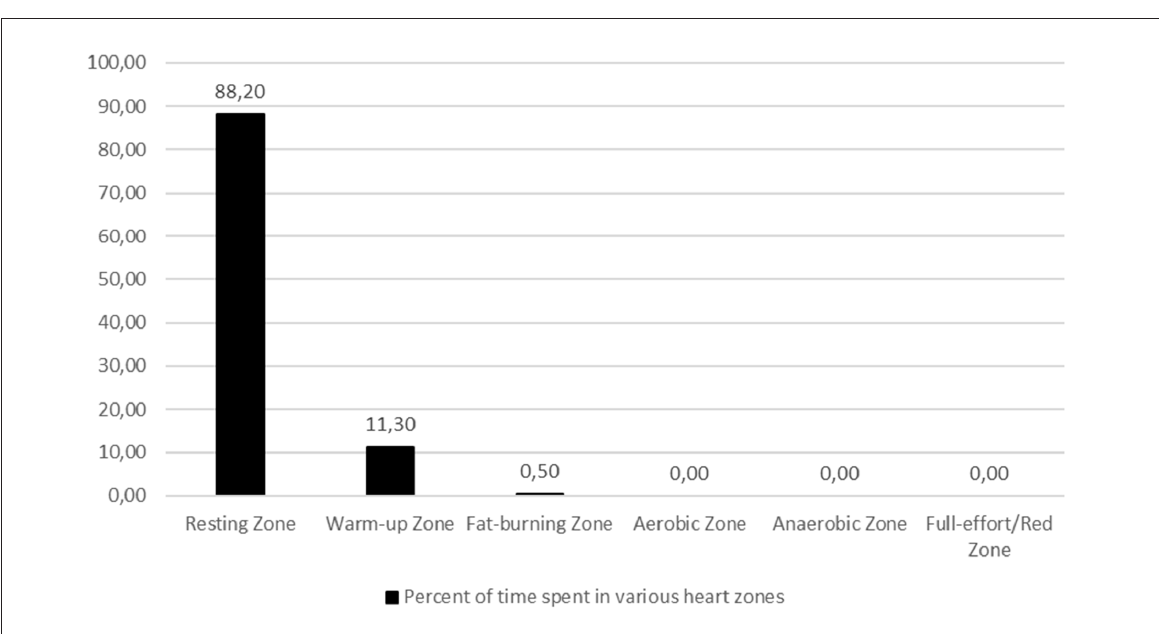
Figure 1. The average percent of time spent in different heart rate zones, based on age-adjusted maximal heart rates, during laughter video watching (n = 10) in Study 1. Note: Resting zone = under 50% of the maximal heart rate (MHR); warm-up zone = 50-60% MHR; fat-burning zone = 60-70% MHR; aerobic zone = 70%-80%; MHR; anaerobic zone = 80-90%; full effort/red zone = > 90%